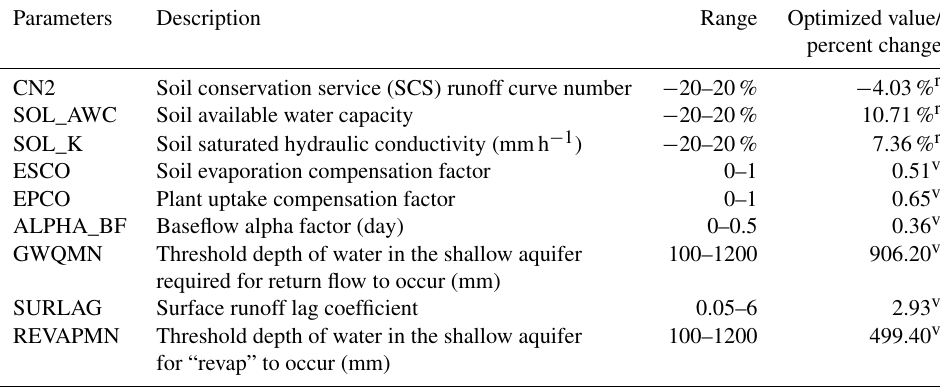
Table 1. Sensitive parameters for streamflow simulation and calibrated values.